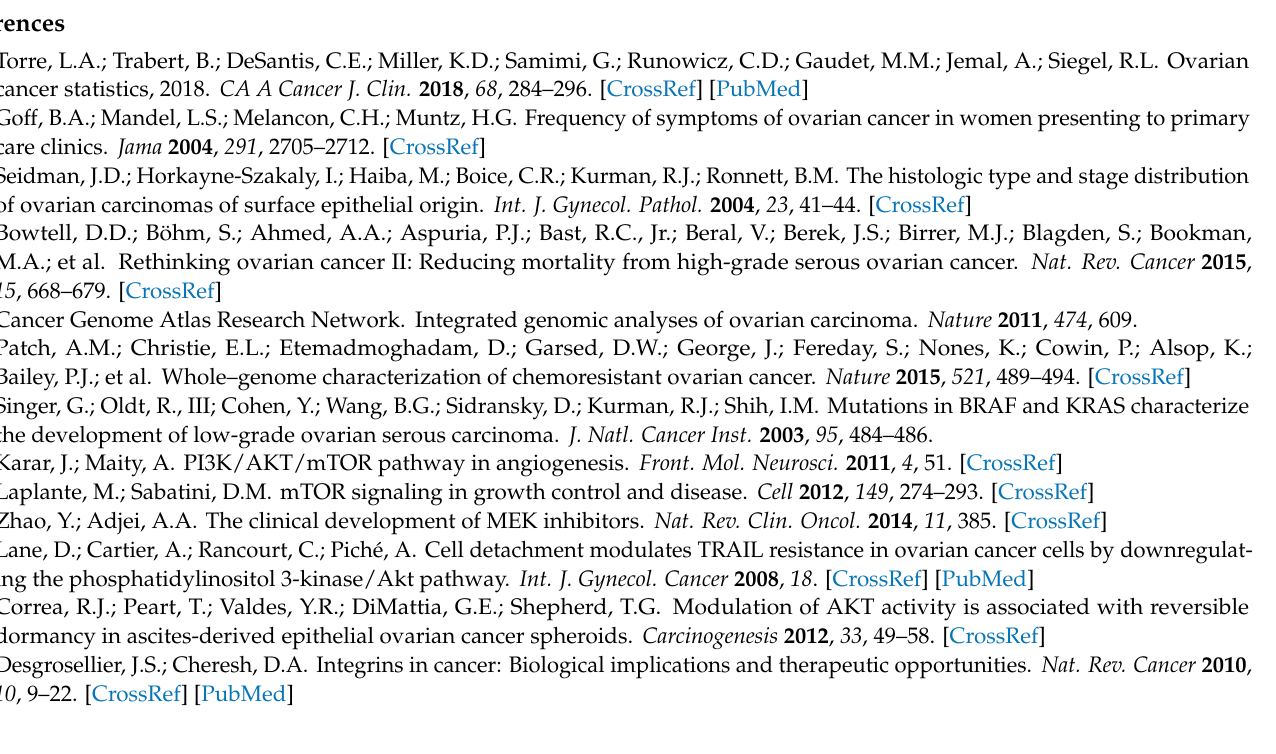
Figure A1. Representative images of 7-day-old spheroids produced by hanging drop culture of OV-90 ( a ) and OVCAR8 cells ( b ). Scale bar is 100 µ m. A box and whisker plots showing distribution in the equivalent diameter ( c ) and sphericity ( d ) of OV-90 spheroids (blue) (n = 43) and OVCAR8 spheroids (green) (n = 35). Equivalent diameter and sphericity were determined using